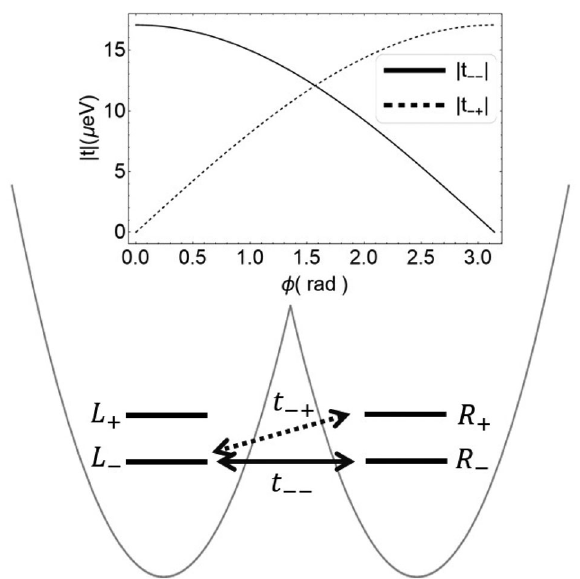
Fig. 1 Electron tunneling in the presence of valleys. Sketch of a double quantum dot with two valley eigenstates in each dot. In the top panel we show the interdot tunnel couplings, both intra- and inter-valley, as a function of the valley phase